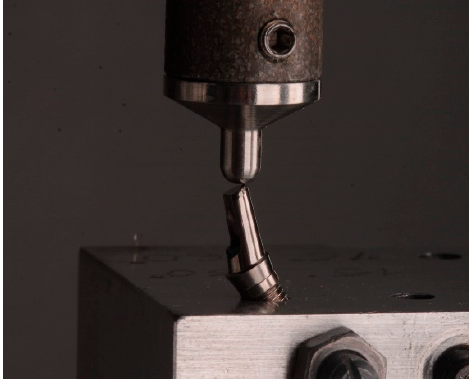
Figure 4. Cyclic loading following ISO 14801.